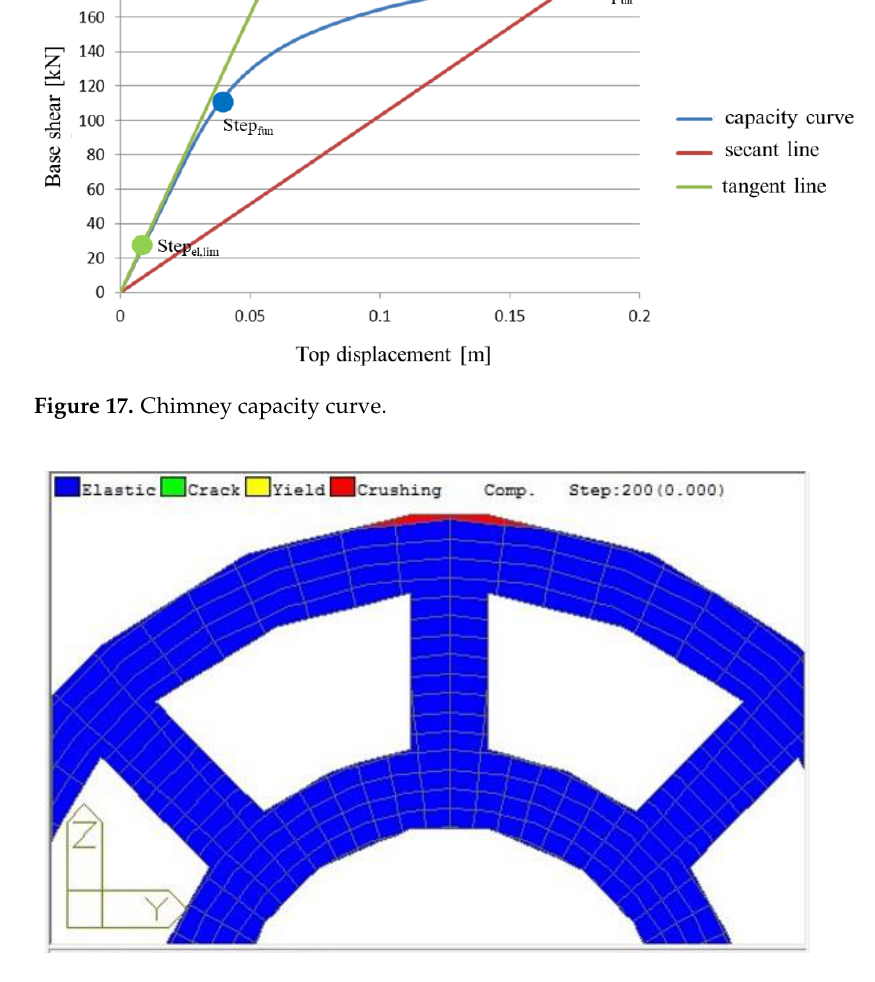
Figure 18. Crushing of the upper edge of the section base due to exceeding the compressive strength.